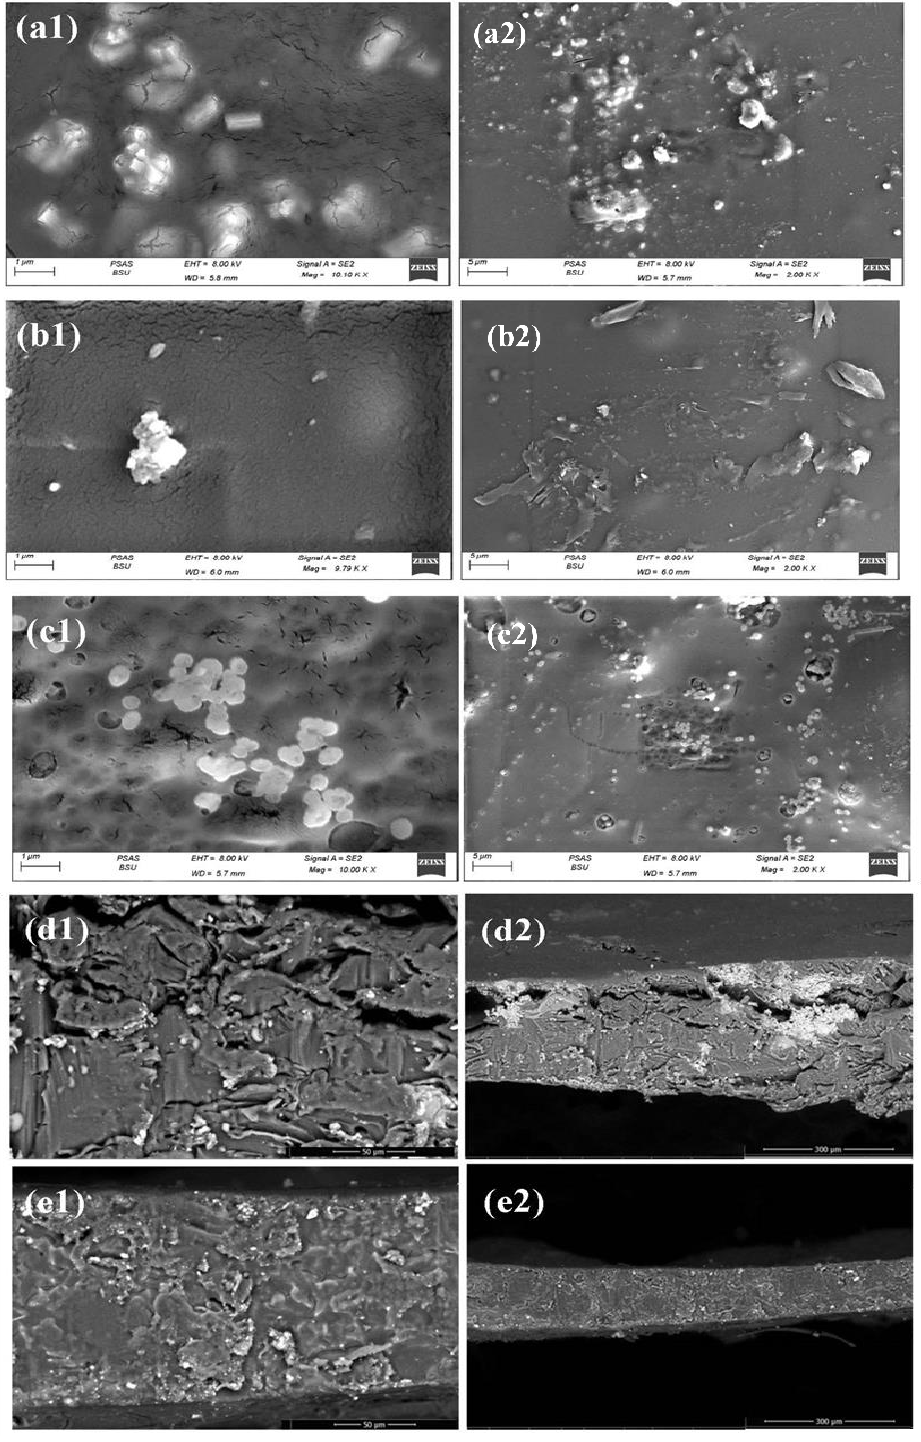
Figure 4. SEM of CA films with a variation of dopants where ( a1 , a2 ) Mg 3 (VO 4 ) 2 @CA film, ( b1 , b2 ) Mg 3 (VO 4 ) 2 /MgO@CA, ( c1 , c2 ) Mg 3 (VO 4 ) 2 /MgO/GO@CA, ( d1 , d2 ) the cross-section of Mg 3 (VO 4 ) 2 /MgO@CA, ( e1 , e2 ) the cross-section of Mg 3 (VO 4 ) 2 /MgO/GO@CA.